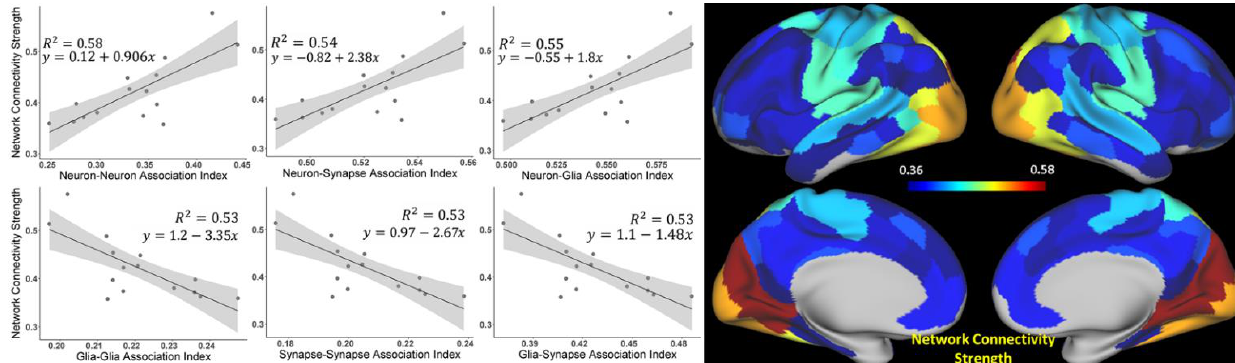
Figure 4. Relationships between network connectivity strength (NCS) and indices characterizing cellular associations between neurons, synapses, and glia cells. Plots show correlations between the resting-state network connectivity strength NCSn and cellular associations strength CAS n (index n is omitted in the figure) of these networks for six types of cellular associations (neuron–neuron, glia–glia, synapse–synapse, neuron–glia, neuron–synapse, and glia–synapse) for 15-networks. Shaded areas indicate 95% confidence intervals. Images represent surface maps of NCS for 15 networks.